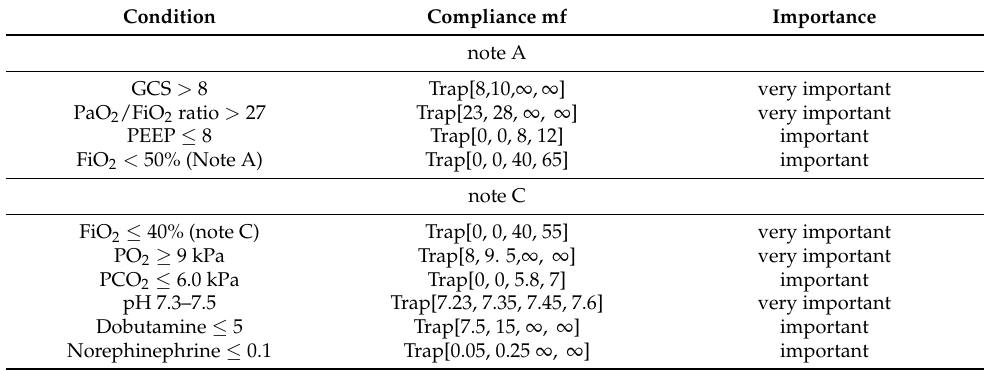
Table 5. Note A + Note C